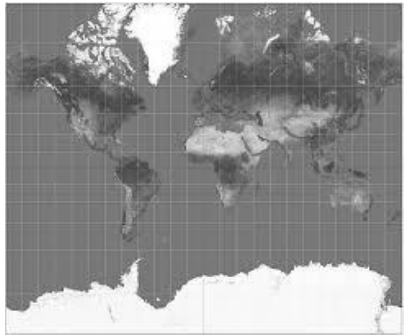
Figure 8: Mercator projection covers the biggest part of the inhabited areas with one rectangle. Source: Wikipedia